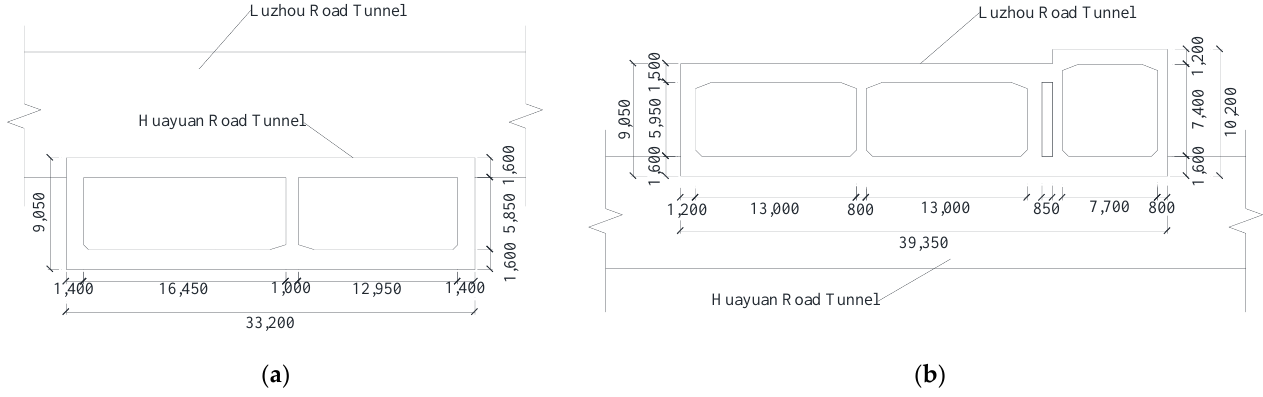
Figure 2. Two orthogonal sections of “Huayuan - Luzhou” Crossing Point: ( a ) Huayuan Road and ( b ) Luzhou Road (unit: mm).